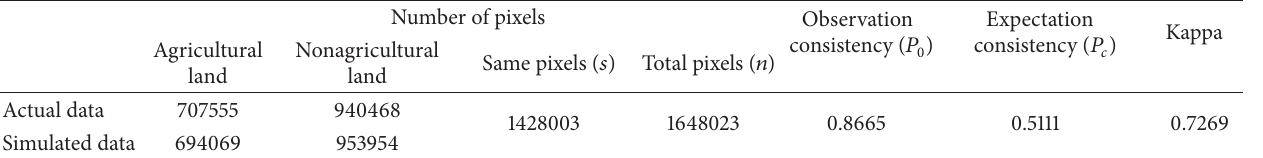
Table 6: Kappa coefficient of agricultural land.